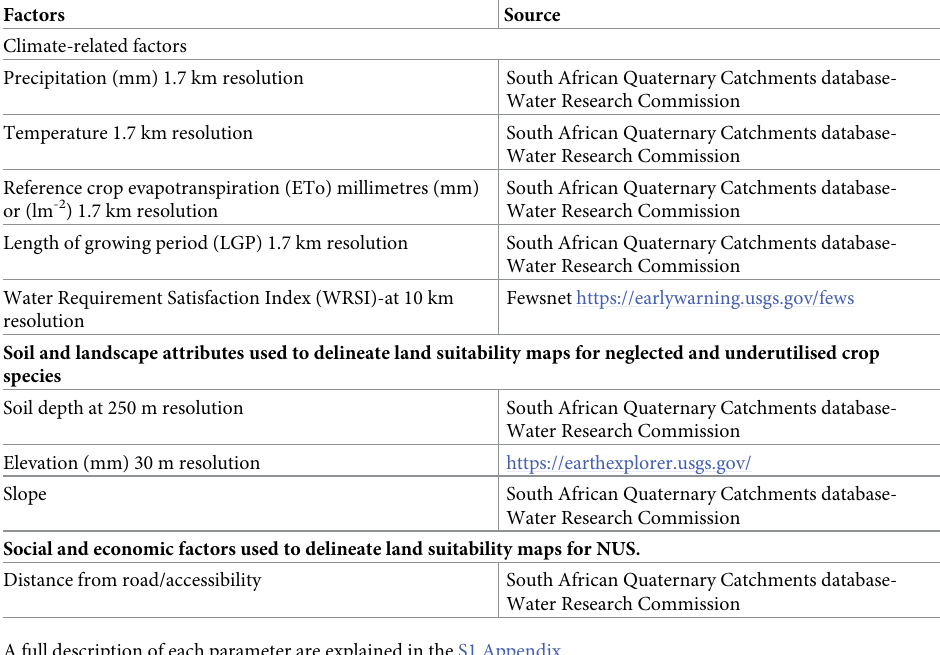
Table 1. Factors used to delineate land suitability maps for neglected and underutilised crop species.